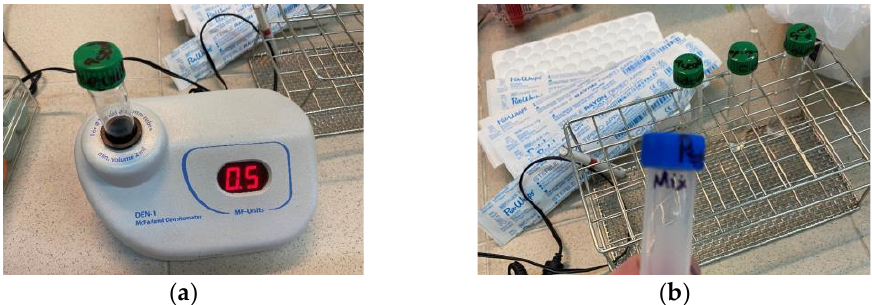
Figure 1. Preparation of the microbial suspensions: ( a ) obtaining the 0.5 McFarland standard for each microorganism; ( b ) the equimolecular microbial-mix obtained from the three 0.5 McFarland suspensions.